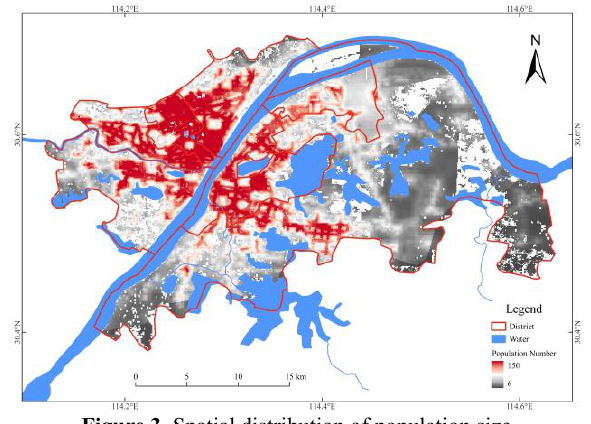
Figure 3 . Spatial distribution of population